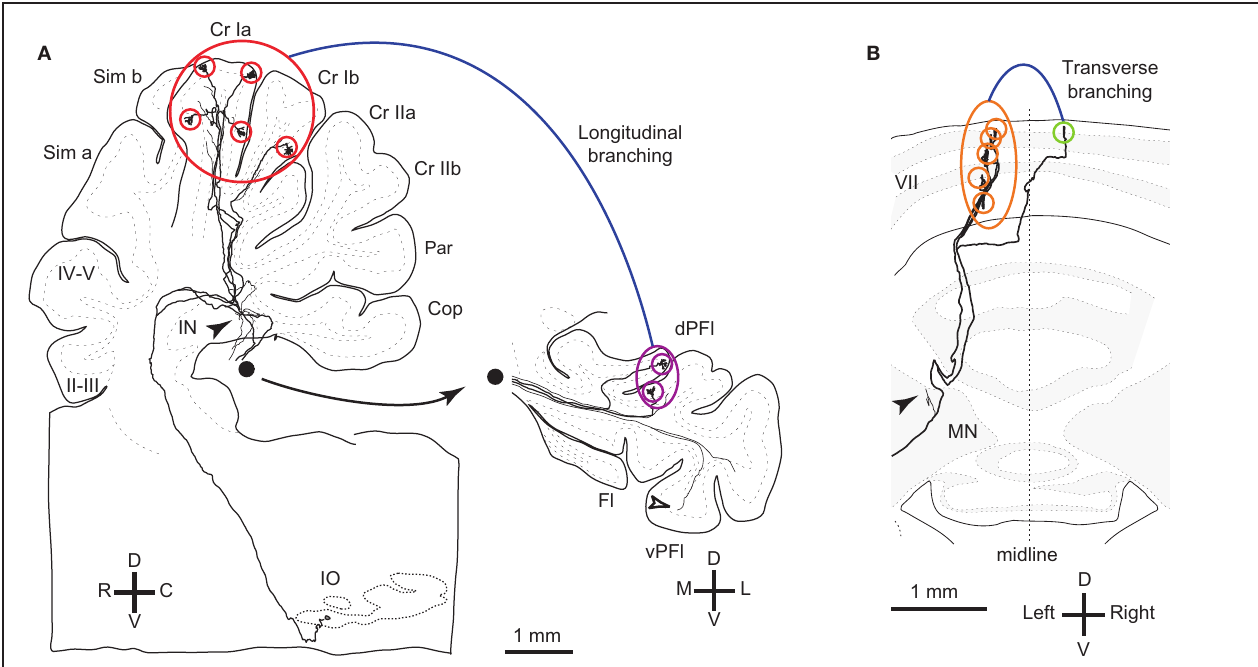
axon as shown in Figure 4B of Sugihara et al., 1999). Abbreviations in this and subsequent figures, I–X, lobules I–X; a-d, sublobules a-d; AIN, anterior interposed nucleus; C, caudal; CF, climbing fiber; Cop, copula pyramidis; Cr I, crus I of ansiform lobule; Cr II, crus II of ansiform lobule; D, dorsal; das, dorsal acoustic stria; DCN, deep cerebellar nuclei; dPFl, dorsal paraflocculus; Fl, flocculus; fp, floccular peduncle; IN, interposed nucleus; IO, inferior olive; L, lateral; LN, lateral cerebellar nucleus; M, medial; MN, medial cerebellar nucleus; p, sublobule p; Par, paramedian lobule; PC, Purkinje cell; pf, primary fissure; PIN, posterior interposed nucleus; R, rostral; Sim, simple lobule; V, v − , ventral; vPFl, ventral